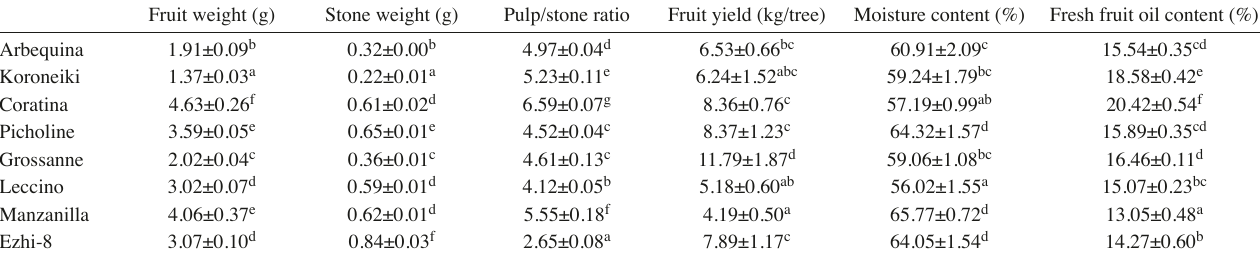
Tab. 2: Fruit characteristics and yield per tree of eight cultivars Fruit weight